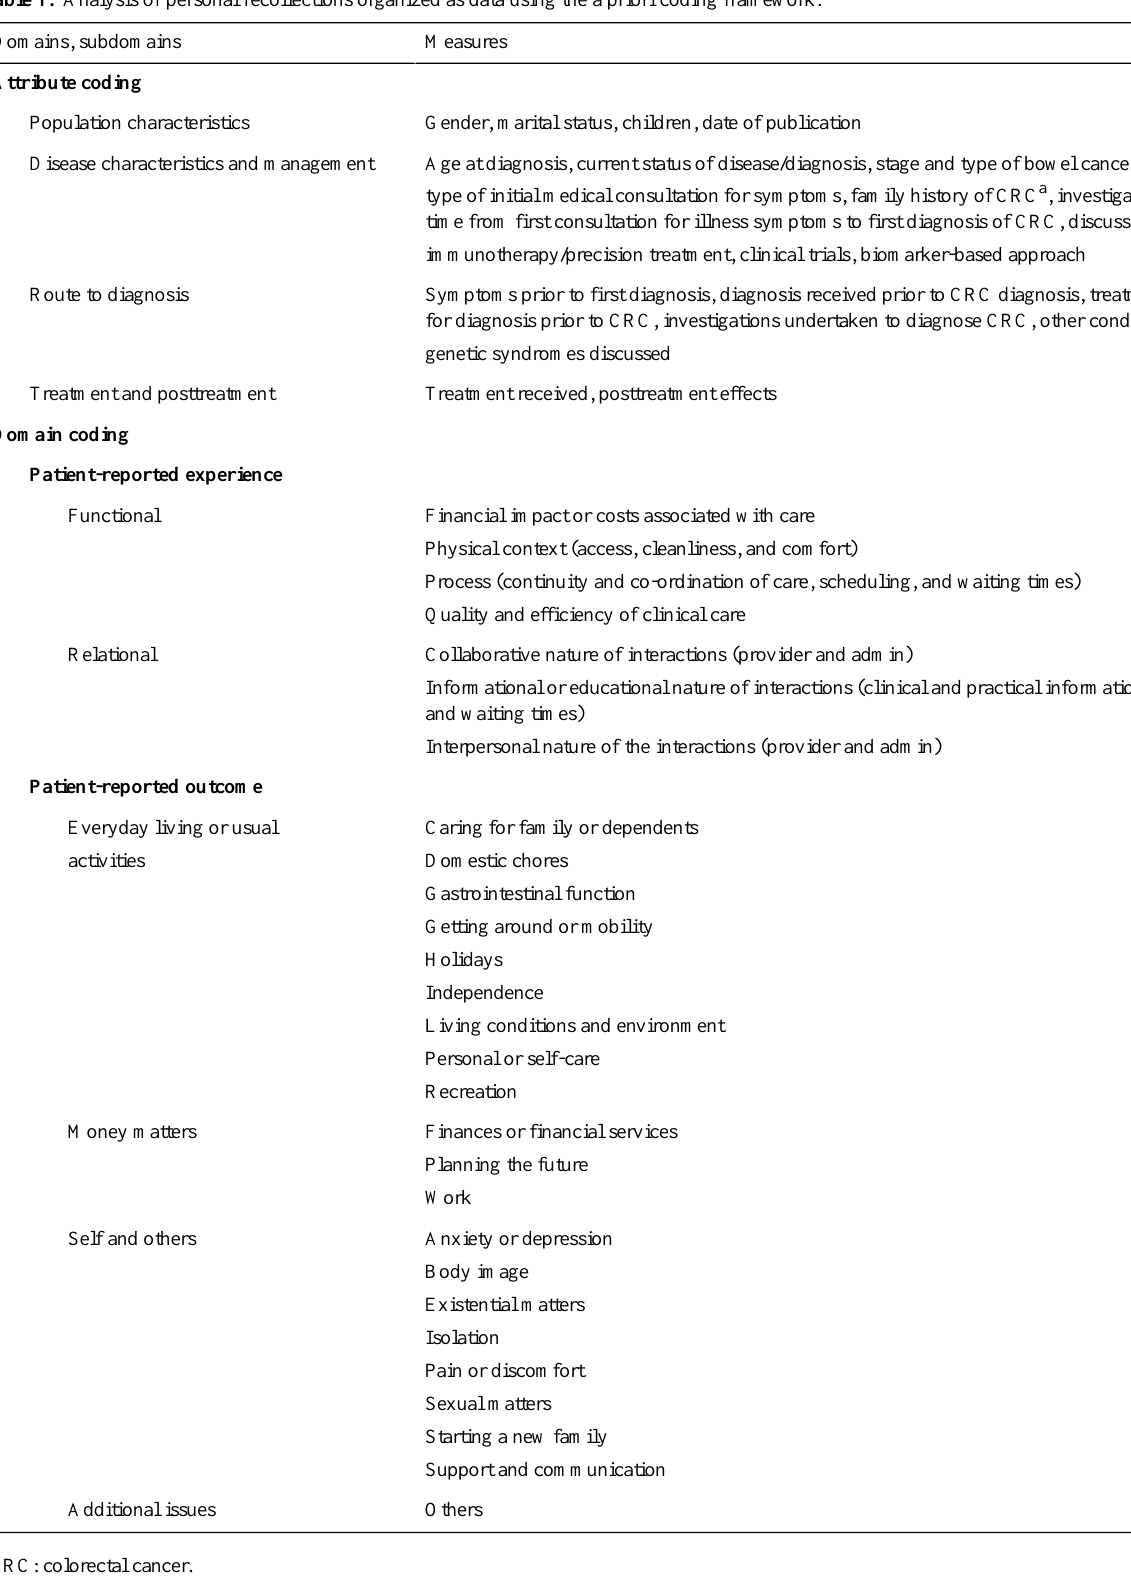
Table 1. Analysis of personal recollections organized as data using the a priori coding